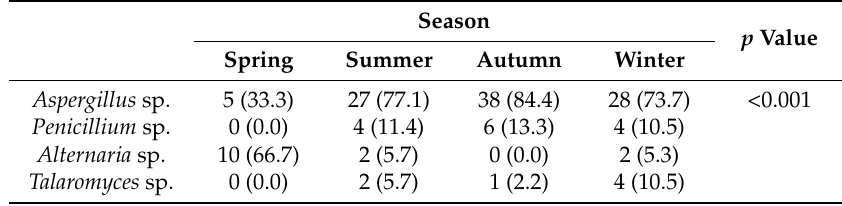
Table 3. Seasonal distribution of four major fungus species in the outside of hospital throughout the